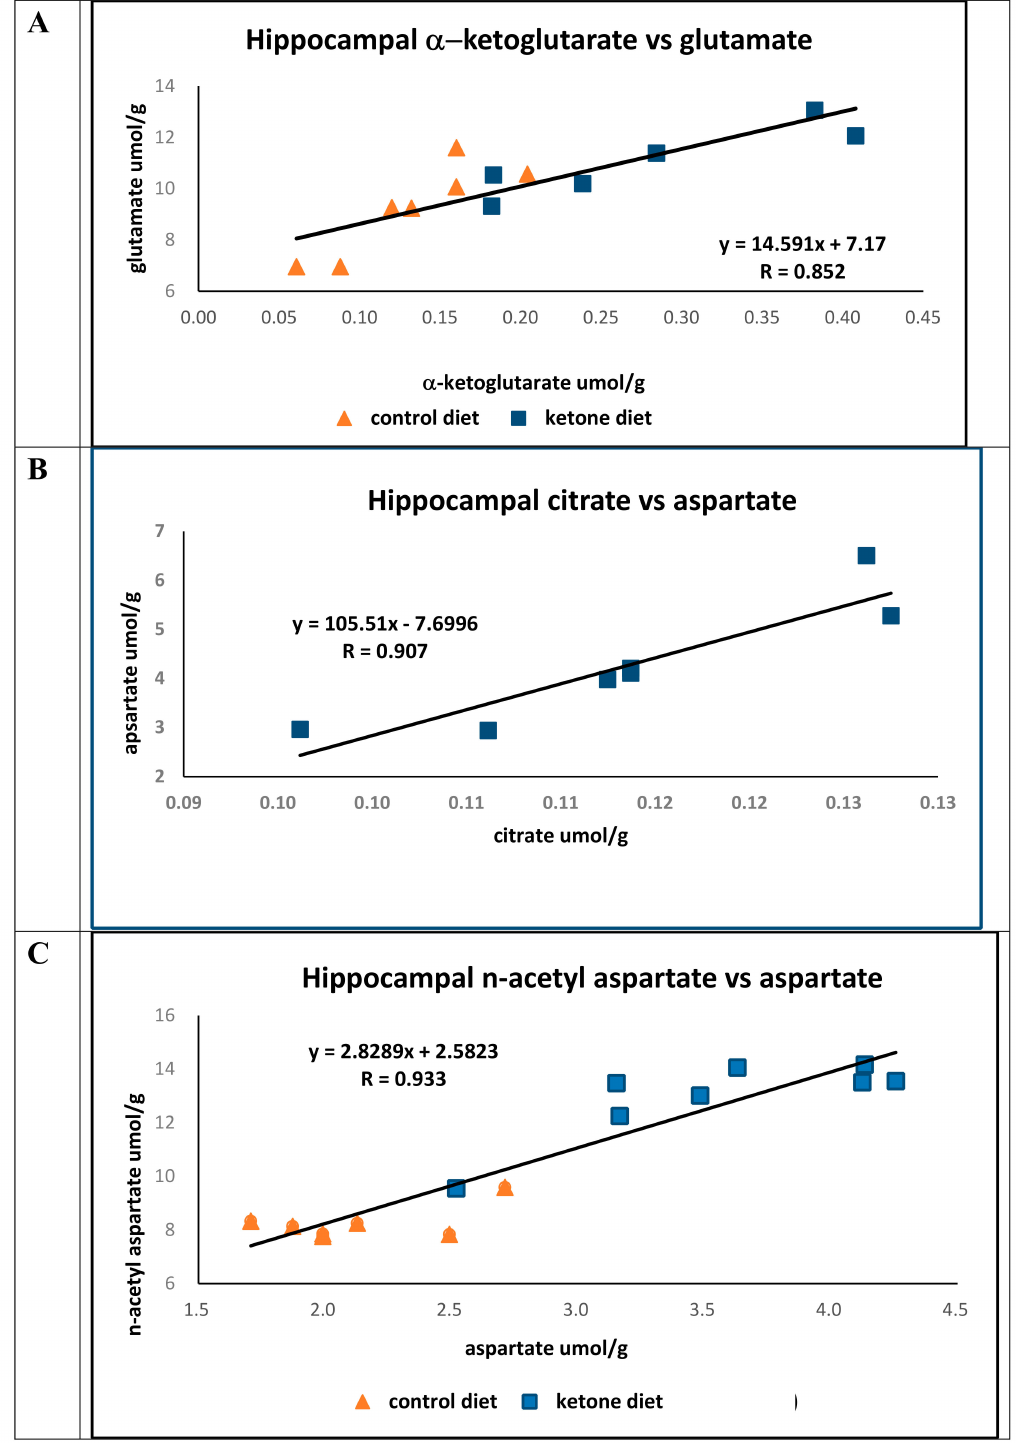
Figure 1. Pearson’s linear correlation comparing concentrations of hippocampal TCA cycle metabolites with their respective amino acids from 3xTgAd mice fed either a control diet (n = 7, triangle) or a ketone ester diet ( n = 7, square) for 8 months, measured at 16.5 months of age. ( A ) Concentrations of α -ketoglutarate versus glutamate, ( B ) concentrations of citrate versus aspartate, and ( C ) concentrations of aspartate versus n-acetyl